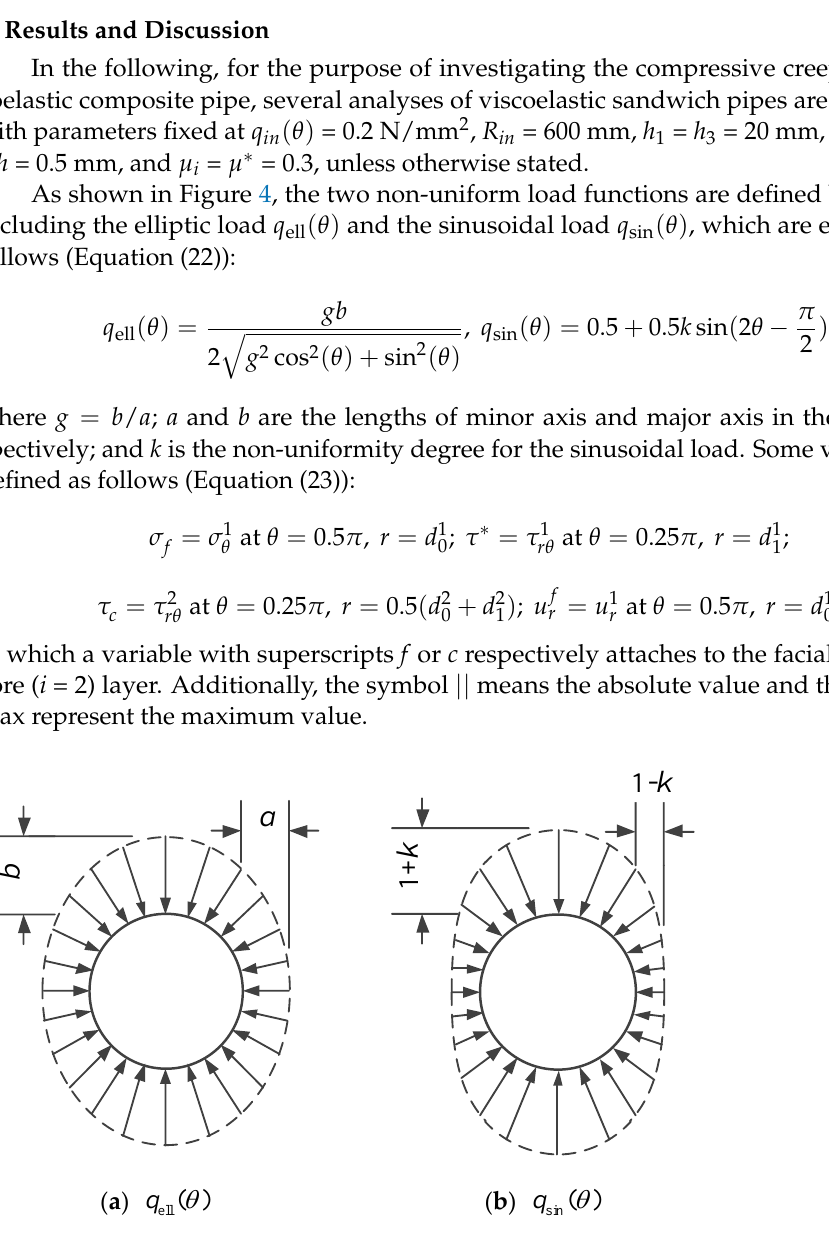
Figure 4. Schema for the elliptic load and the sinusoidal